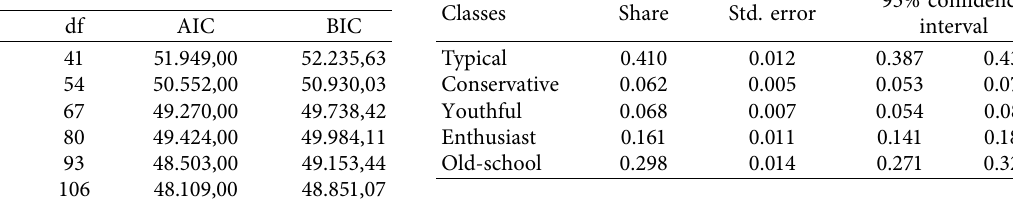
Table 2: Statistics for determining the optimal number of classes in seven European countries.